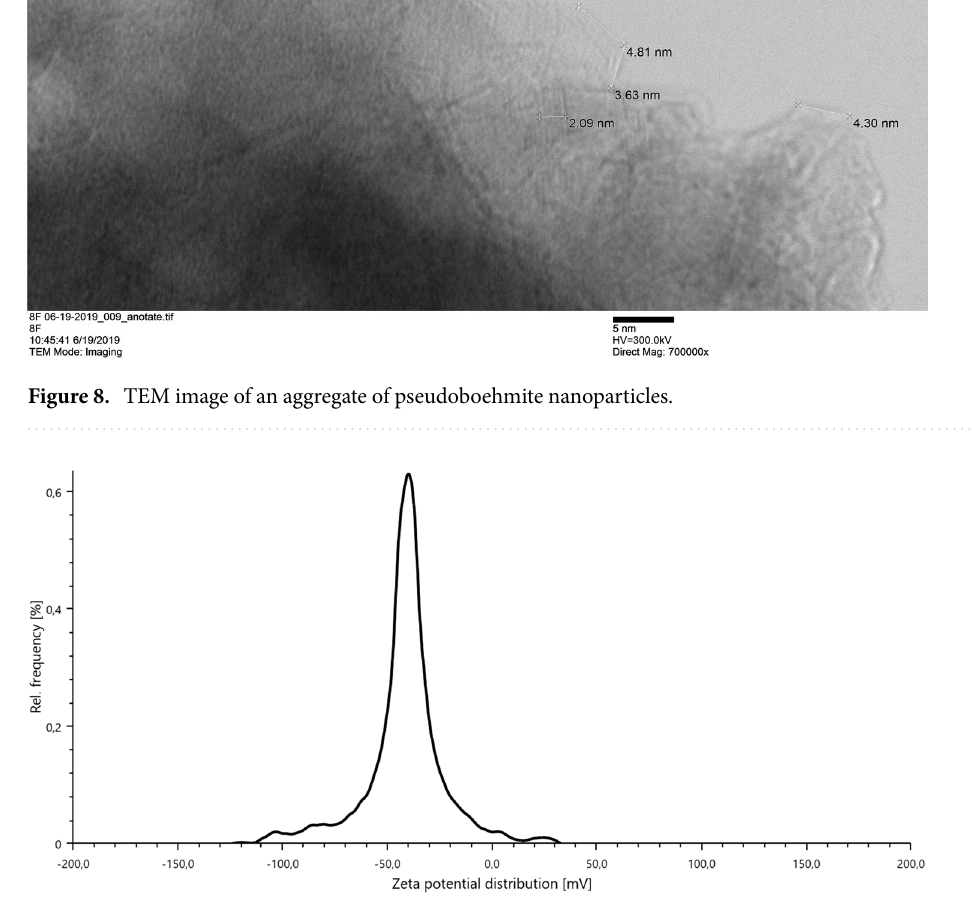
Figure 9. Zeta potential of pseudoboehmite